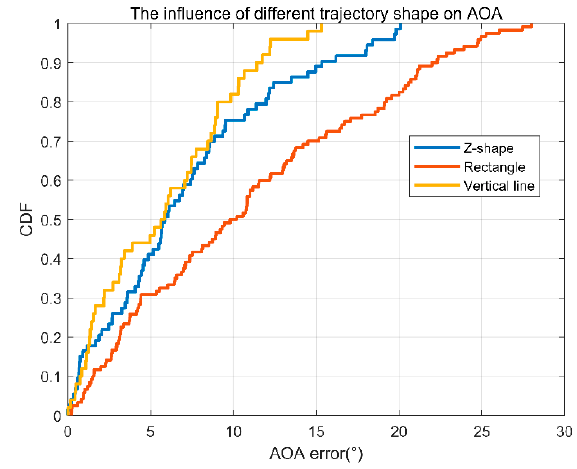
Figure 17. AOA error accumulation diagram of three different shapes’ Trajectories. (5) Different directions of motion.